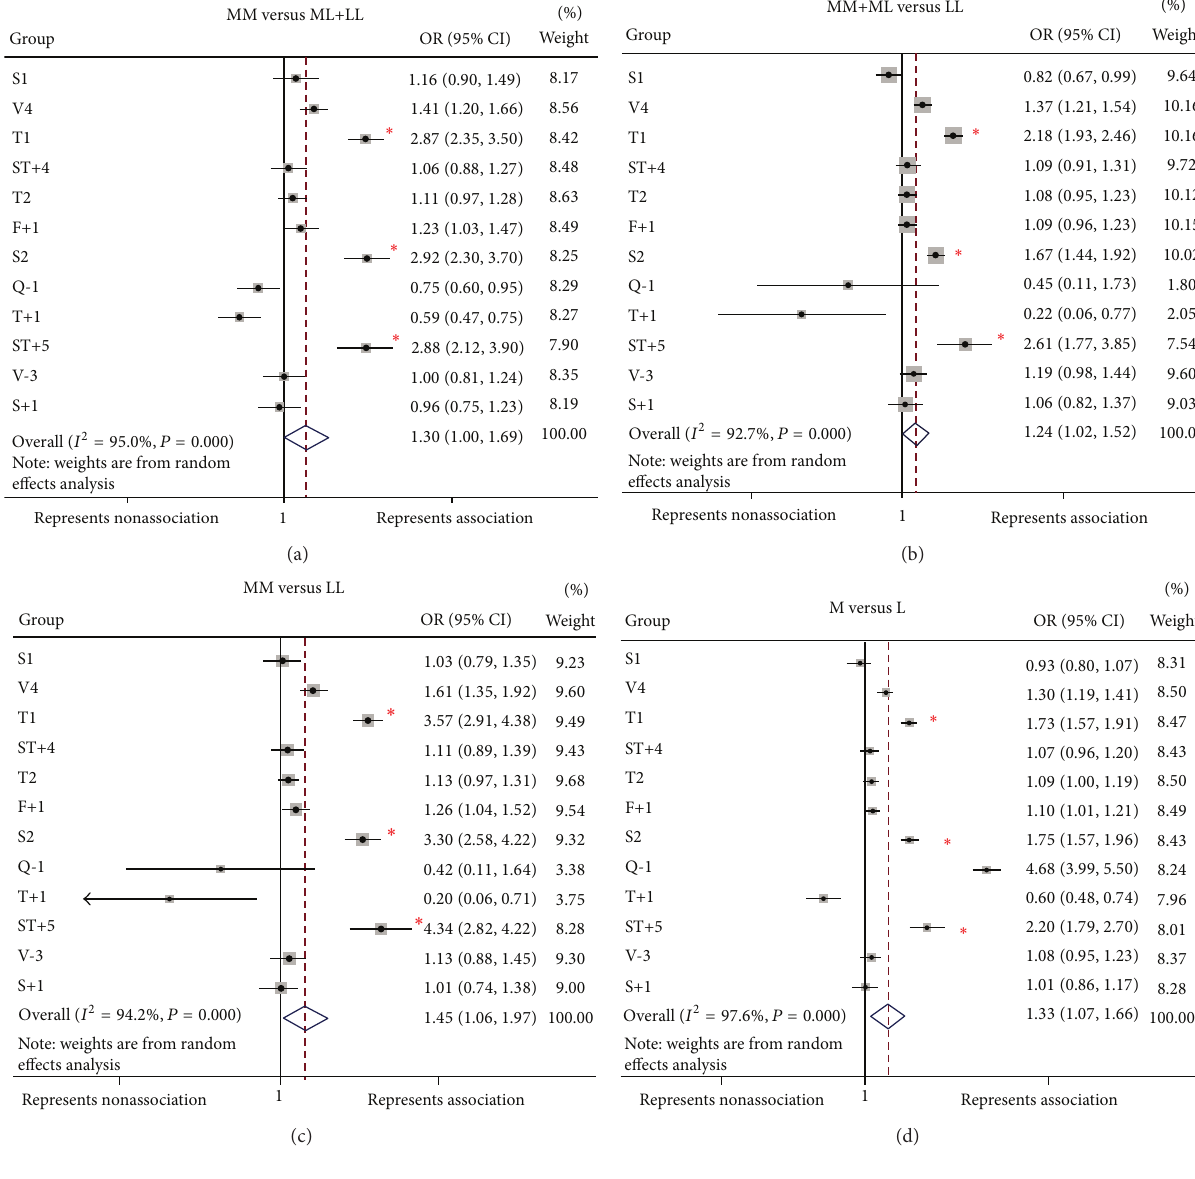
Figure 3: Forest plots from my meta-analysis study on Asian population. (a) MM versus LL+LM, (b) MM+ML versus LL, (c) MM versus LL, and (d) M versus L, where M is mutant allele, L is wild-type allele, LL is homozygous normal genotype, LM is heterozygous genotype, and MM is homozygous mutant genotype. ∗ Significant associations with odds ratios from 1.67 to 4.34 in the overall population under different